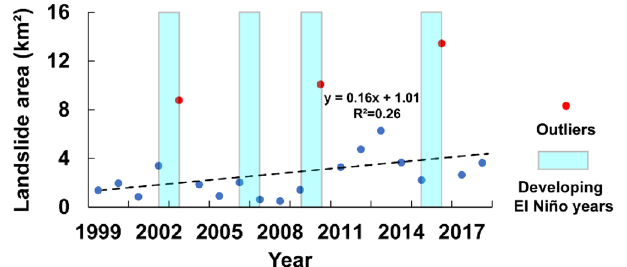
Figure 6. The orange scatterplot shows the temporal distribution of landslide area; blue shaded areas are developing El Niño years 38 . Red dots are outliers based on Thompson’s Tau 37 . The black dotted line is a linear-fit trendlines line of landslide area without outliers.